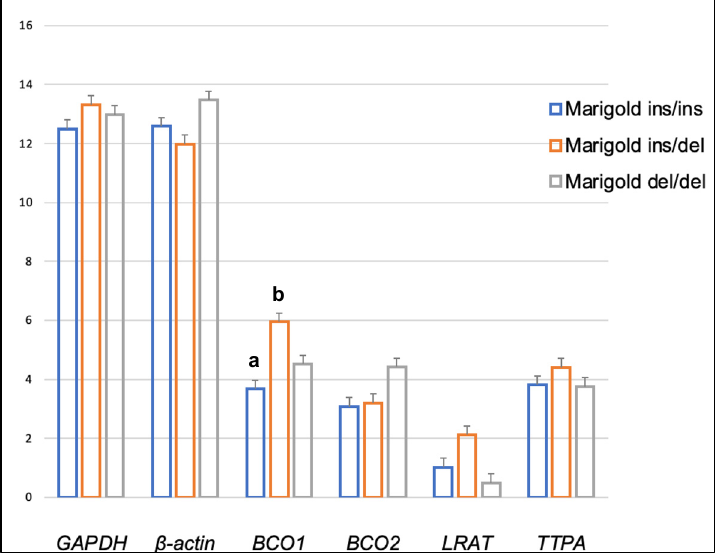
Figure 6. Relative BCO1 , BCO2 , LRAT, and TTPA mRNA levels (log2 abundance) in the brain of rabbits with different genotypes at codon 248 of the BCO2 gene (ins/ins vs. ins/del vs. del/del) fed a diet with the addition of Aztec marigold flower extract. GAPDH and ß-actin were used as reference genes. Data represent posterior means (expressed as arbitrary units) ± SEM (standard error of the mean). Means followed by the different superscripts (a, b) differ significantly ( p ≤ 0.05).